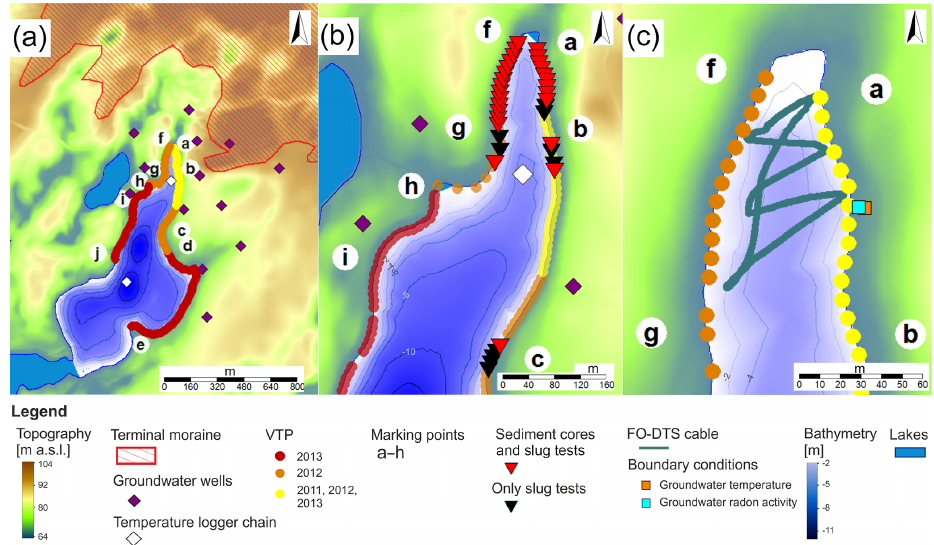
Figure 1. Study site and experimental infrastructure. (a) Overview of the study site with VTP measurement and locations of groundwater wells and temperature logger chains, (b) slug test and sediment core sampling locations and (c) FO-DTS cable installation in the northern part of the lake. Table 1. Dates, boundary conditions and use of vertical temperature profile surveys. Groundwater Lake water Data